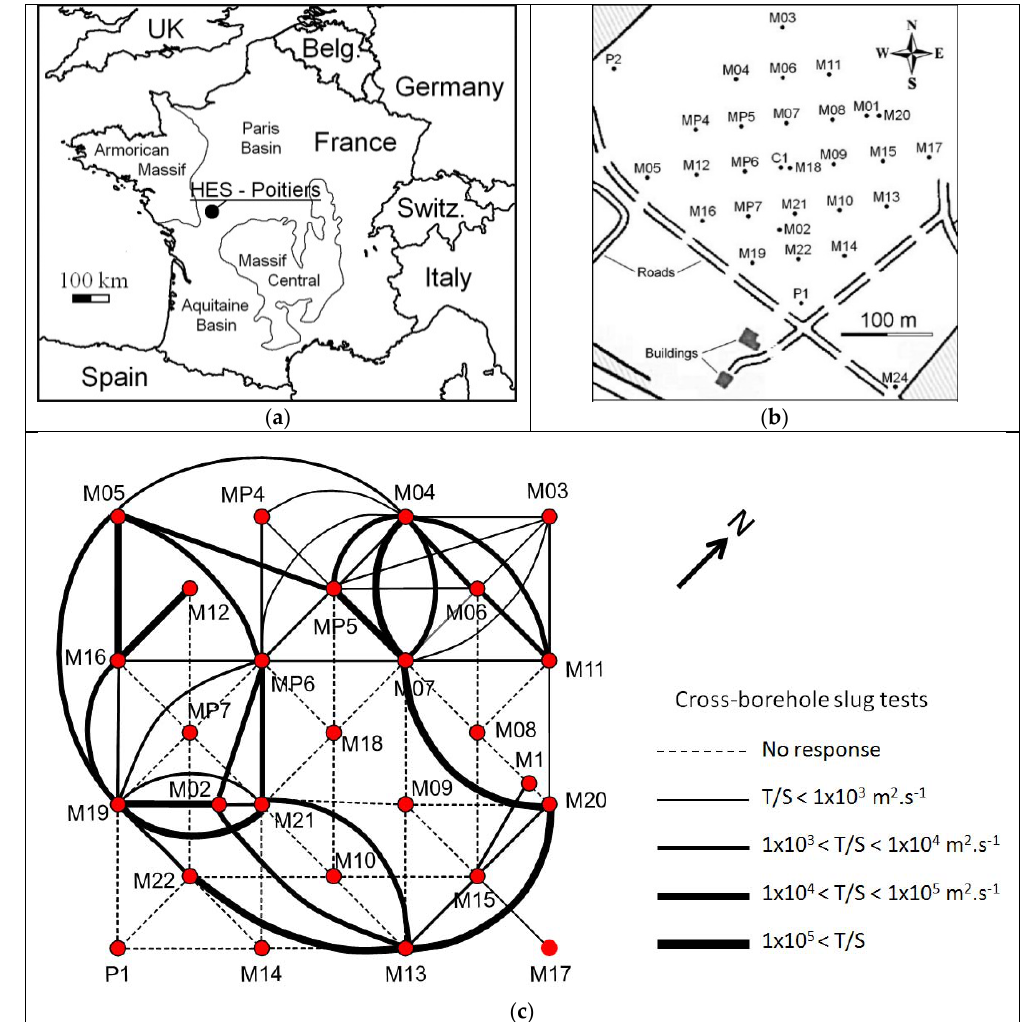
Figure 1. Hydrogeological experimental site in Poitiers. ( a ) Site map, ( b ) well location, ( c ) diffusivity map inferred from slug tests.